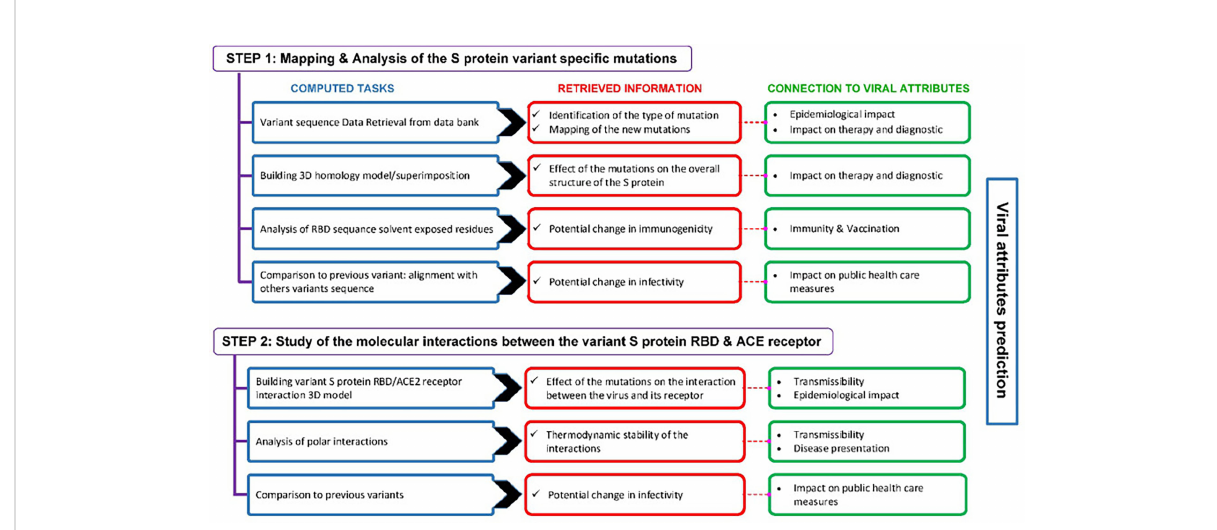
FIGURE 3 Outline of the computational approach used to predict the viral attributes of SARS-CoV-2 emerging variants. This two-step approach includes a number of computed tasks from which various predictions are retrieved. The predictions are linked to the viral attributes and the criteria that apply are used to label a given